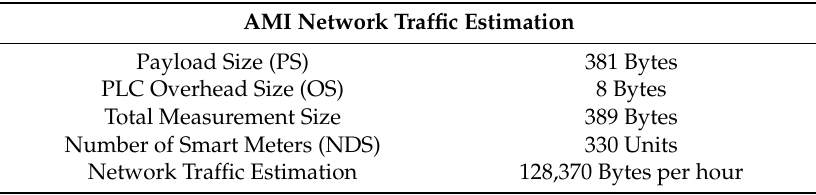
Table 2. The communication network traffic